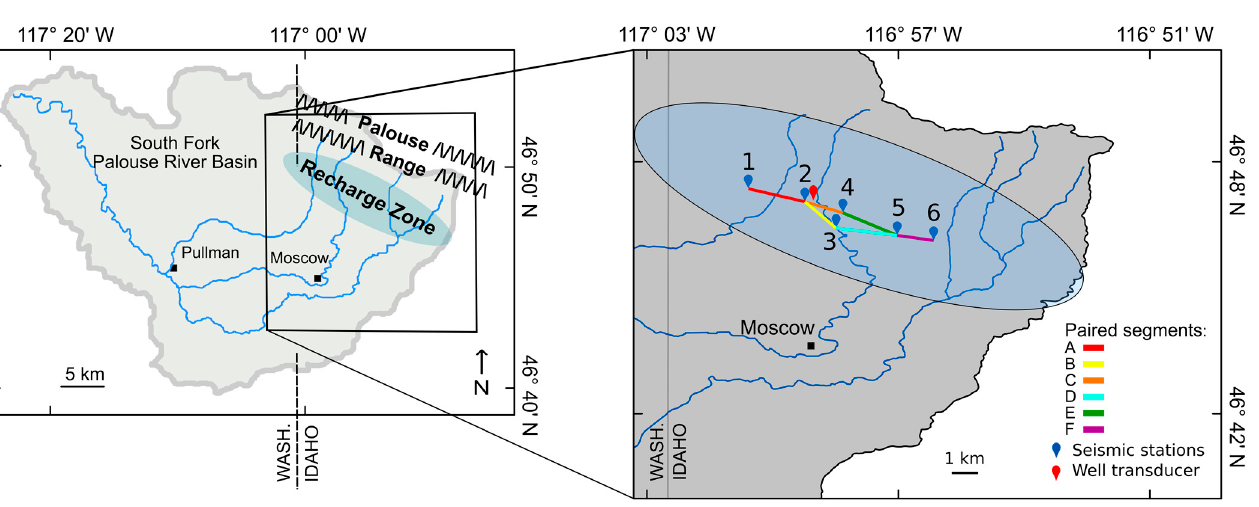
Figure 5. Seismic station locations and station pairs (paired segments) in the study area that is part of the theorized recharge zone along the Palouse Range. Table 2. Station pairs and associated network segments.